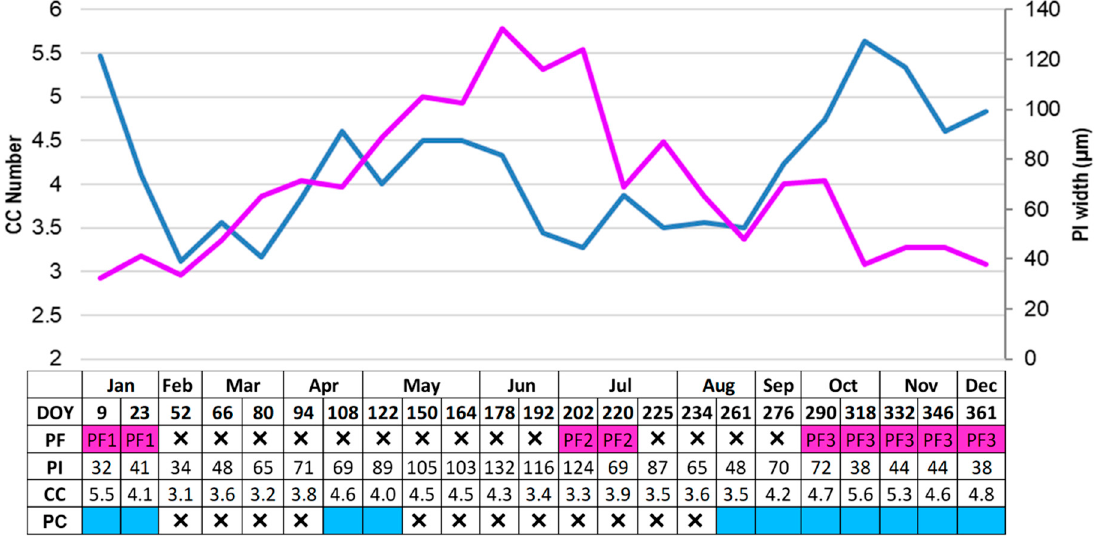
Figure 5. The graph shows the number of cambial cells (CC, blue line) and phloem increments distance (PI, violet line) between CC and the nearest phloem fibres cluster (PF) in Q. ilex . The scheme below the X -axis indicates the occurrence timing of new formed PF groups (PF1, PF2, PF3 in violet square) and PC (cells with primary wall in blue square) in different periods of the year. X × = no PF or PC (post-cambial) cells detected. DOY, day of the year from January to December 2017.